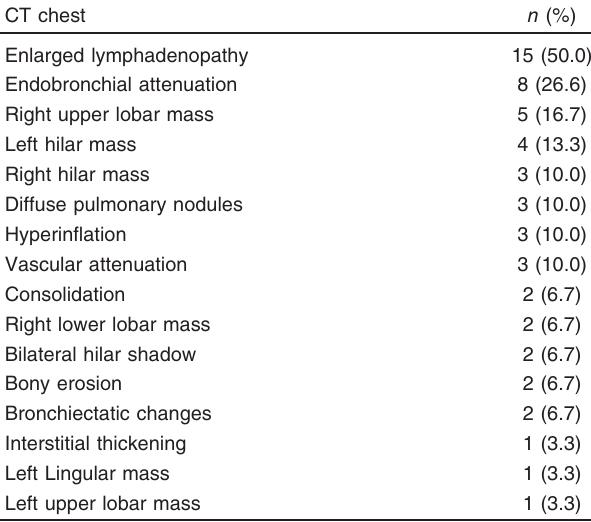
Table 2 Abnormal computed tomography findings of the diseased group (group A) CT chest